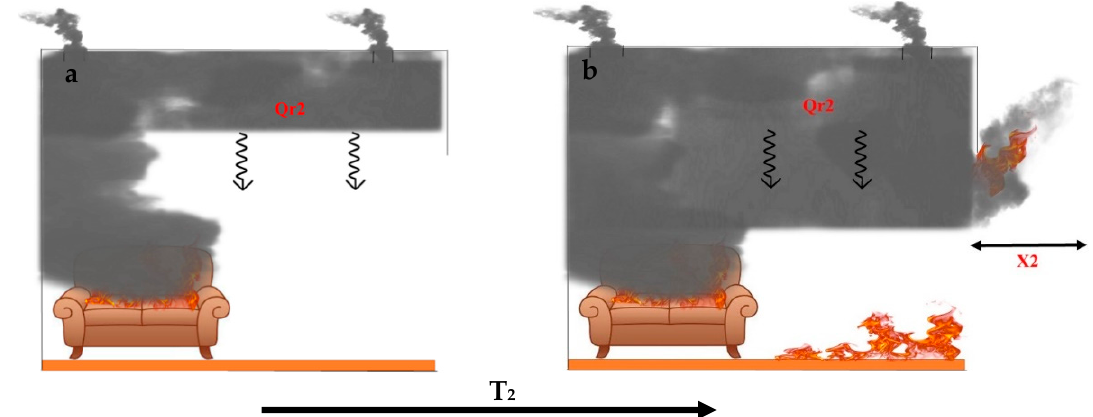
Figure 4. Illustration of pre-flashover ( a ) and post-flashover ( b ) conditions inside a dwelling with horizontal and vertical openings.